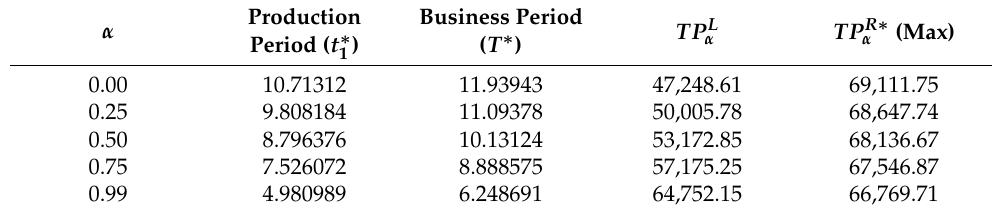
Table 9. Optimum results of Example 3 for maximizing TP R α .